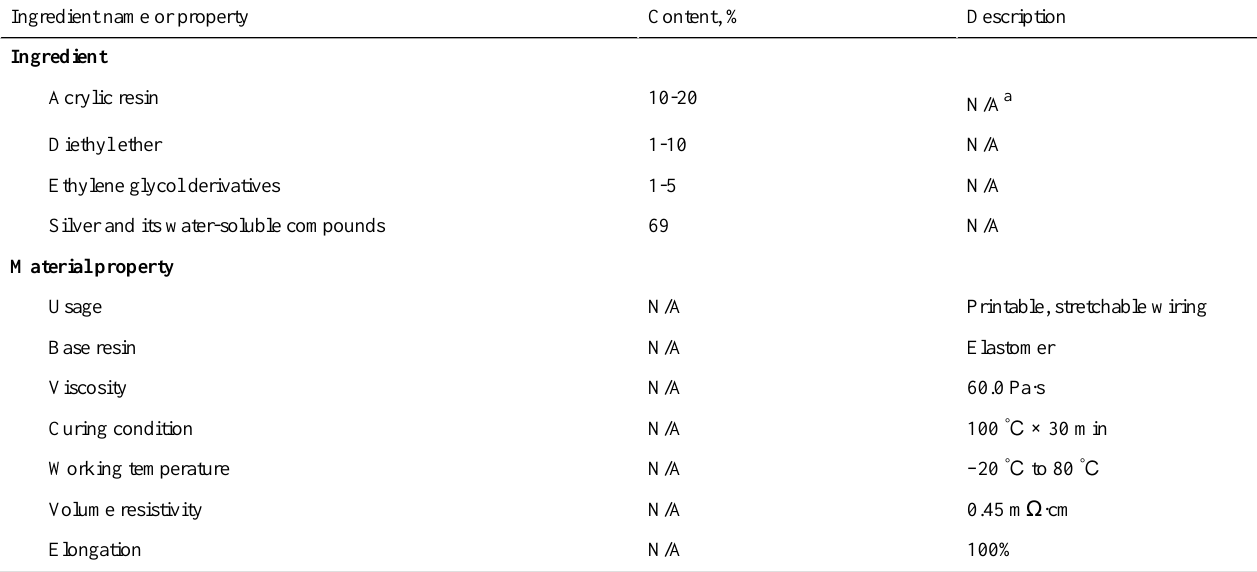
Table 1. Ingredients and material properties of the conductive resin XX-ECA05 (CEMEDINE Co